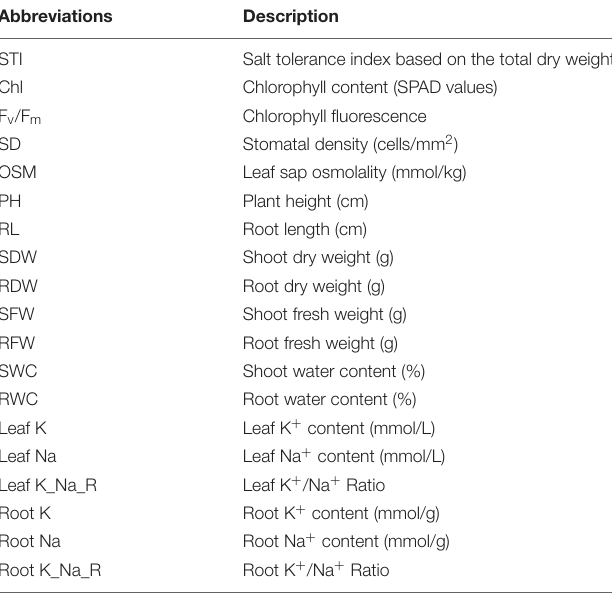
TABLE 2 | The list of traits tested in salt tolerance